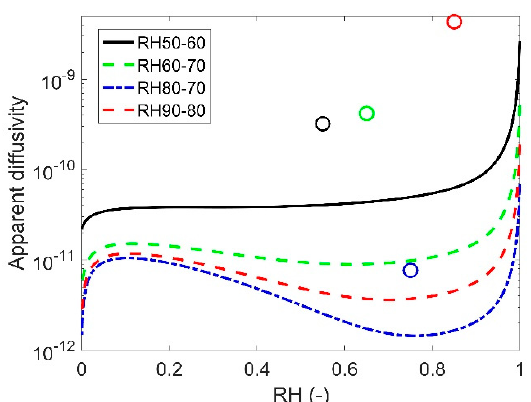
Figure 3. The apparent diffusivity calculated by the proposed model (lines) and Equation (3) (circles). In the proposed model, the contact time t c is taken as 1000s and K t is calculated by the exponential function. Each color corresponds to one condition.